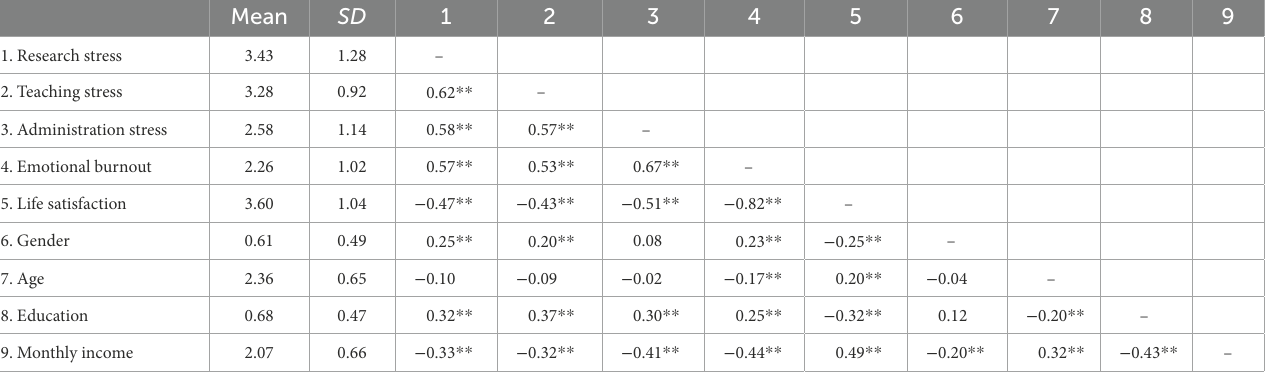
TABLE 2 Descriptive statistics and correlations among study